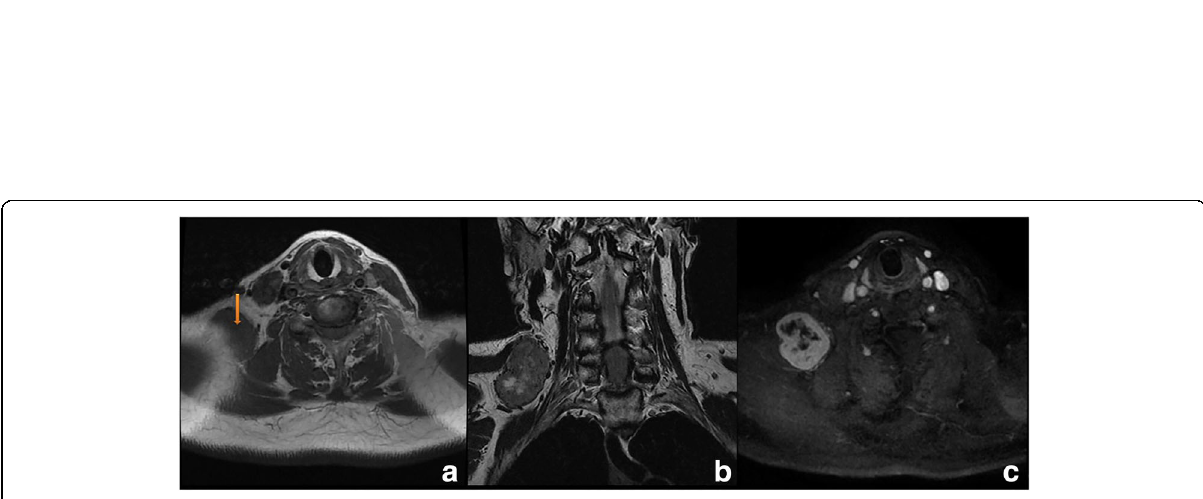
Fig. 13 Somatic SFT of the right supraclavicular fossa. MR images showing a large, well-defined enhancing mass at the right supraclavicular fossa. The tumor demonstrates signal isointensity relative to muscle on T1-weighted images ( a ), slight hiperintensity on T2-weighted images ( b ) and avid enhancement, with some non enhancing areas due to tissue necrosis on the contrast-enhanced MR images ( c